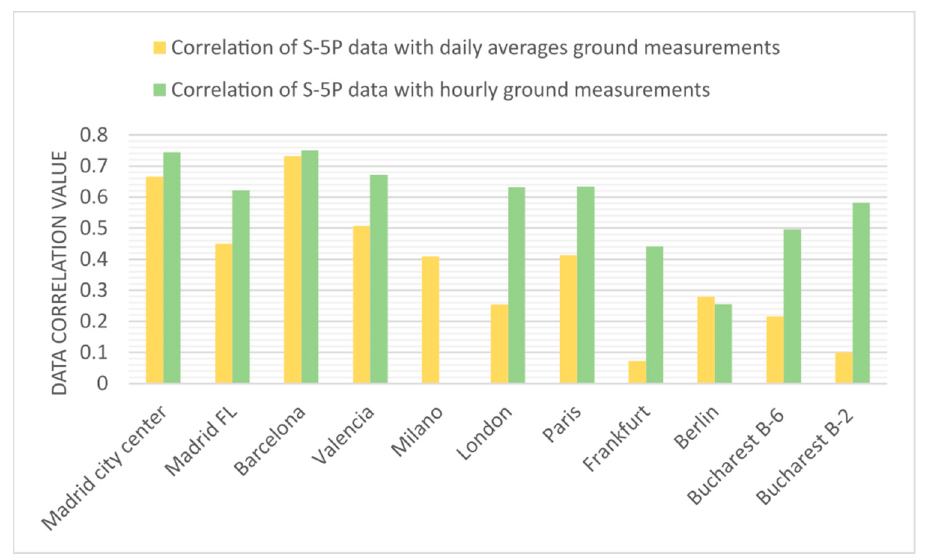
Figure 12. Data correlation difference between S-5P data and daily averages vs. hourly ground measurements. For Milano, hourly measurements were not available.